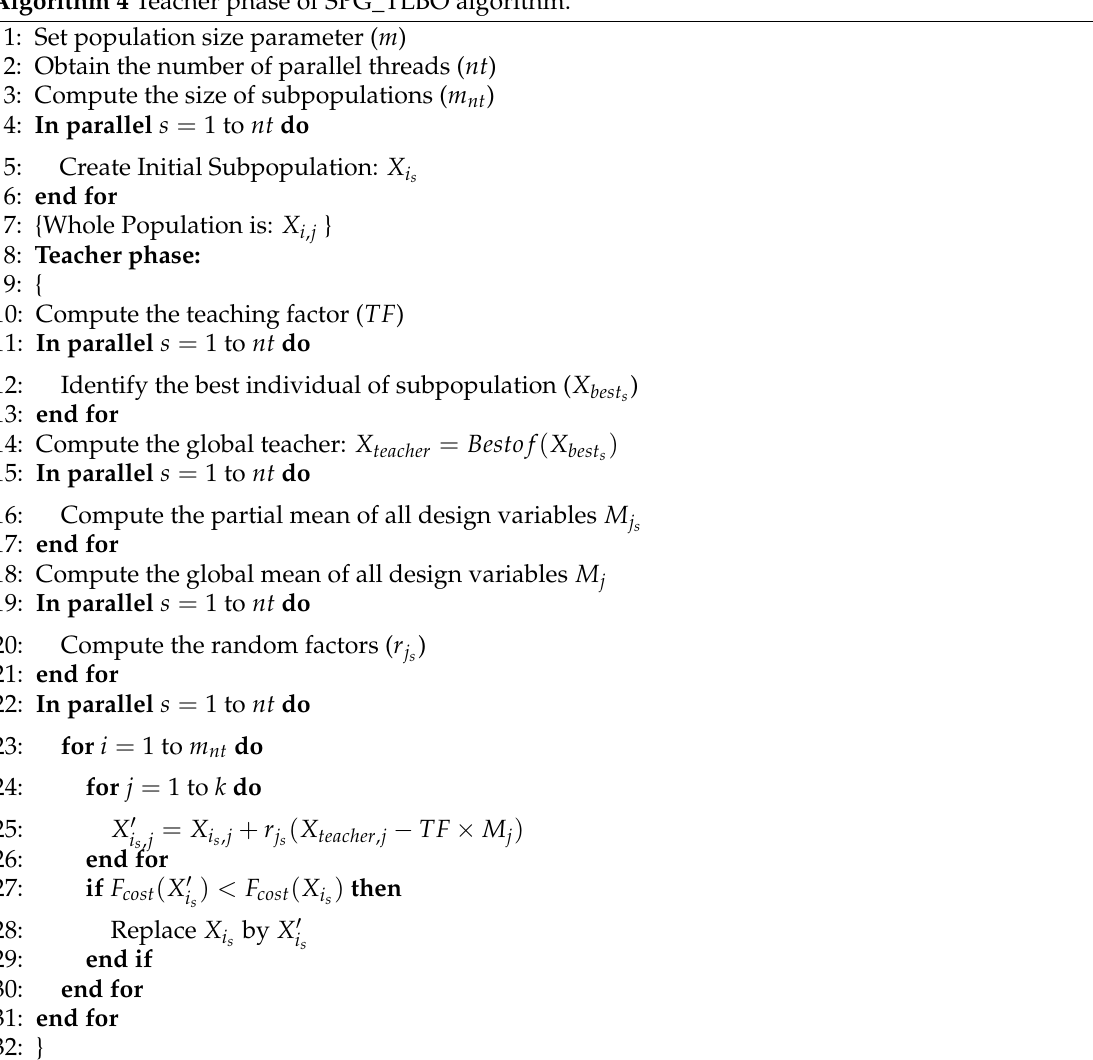
Algorithm 4 Teacher phase of SPG_TLBO